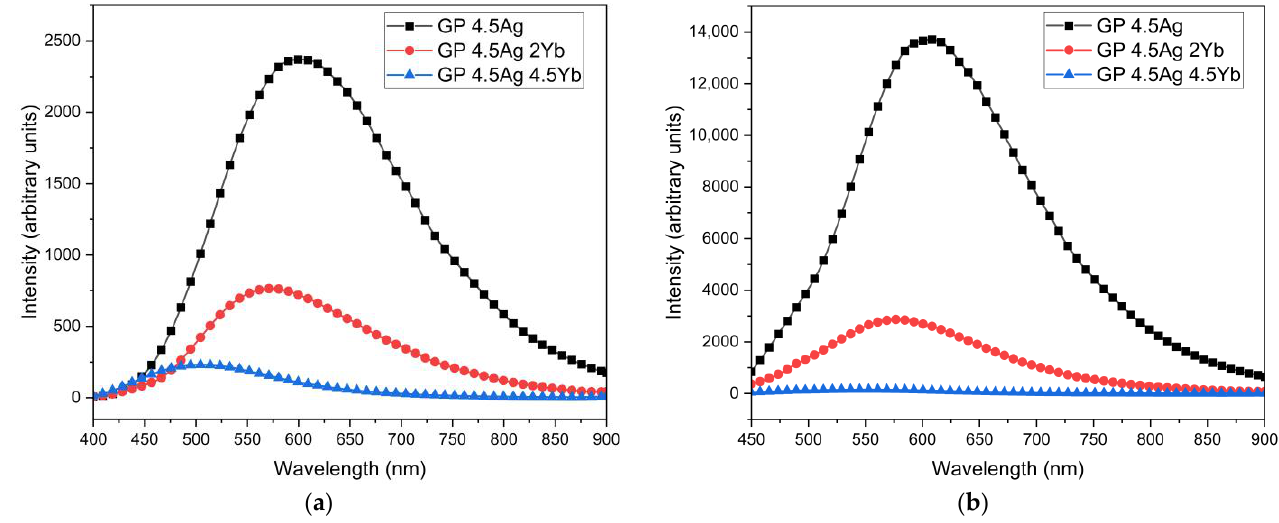
Figure 2 . PL spectra of GP 4.5Ag, GP 4.5Ag2Yb, and GP 4.5Ag4.5Yb samples under excitation at ( a ) 355 nm and ( b ) 405 nm.